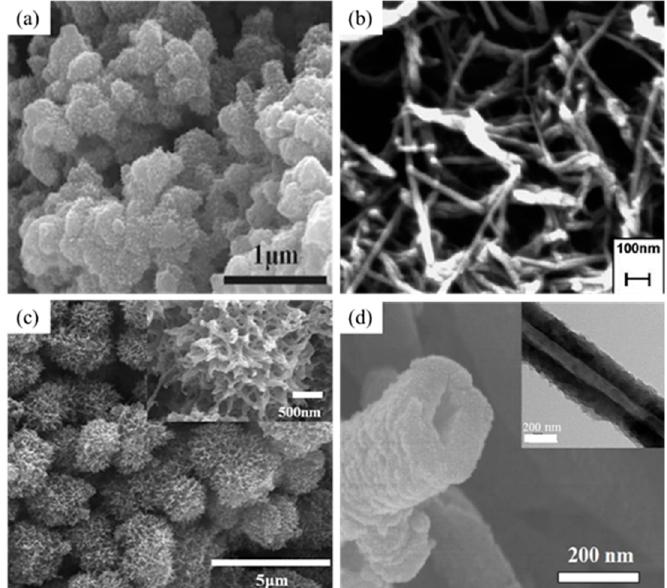
Figure 3. SEM images of synthesized polyaniline (PANI): ( a ) spheres, reprinted with permission from [55]; Copyright Spring Nature, 2013; ( b ) fibers, reprinted with permission from [52]. Copyright American Chemical Society, 2009; ( c ) urchin-like, reprinted with permission from [56]. Copyright John Wiley and Sons, 2009; and ( d ) nanotubes, reprinted with permission from [57]. Copyright American Chemical Society, 2006.